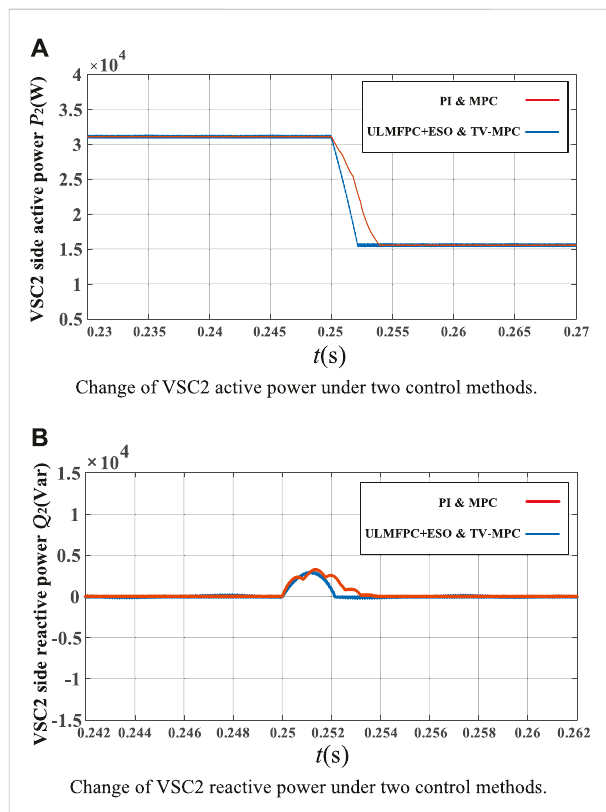
FIGURE 15 (A) ChangeofVSC2activepowerundertwocontrolmethods. (B) Change of VSC2 reactive power under two control